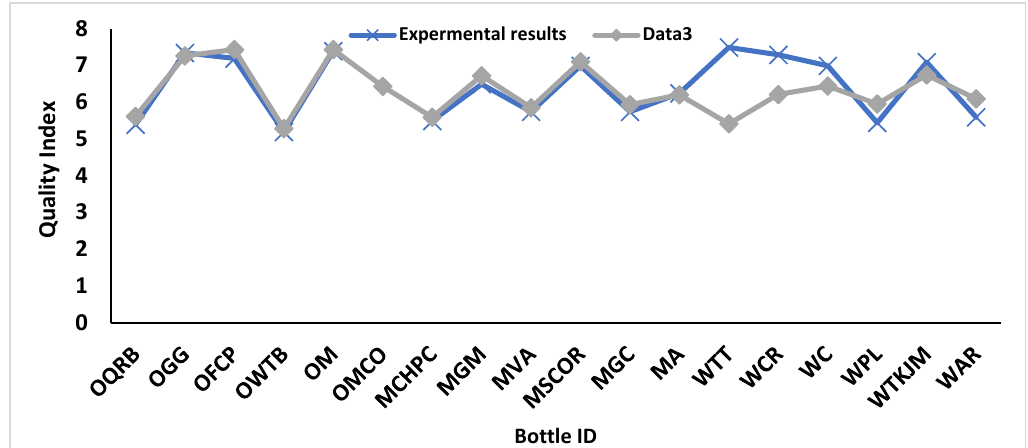
Figure 10. Wine quality prediction for data3.